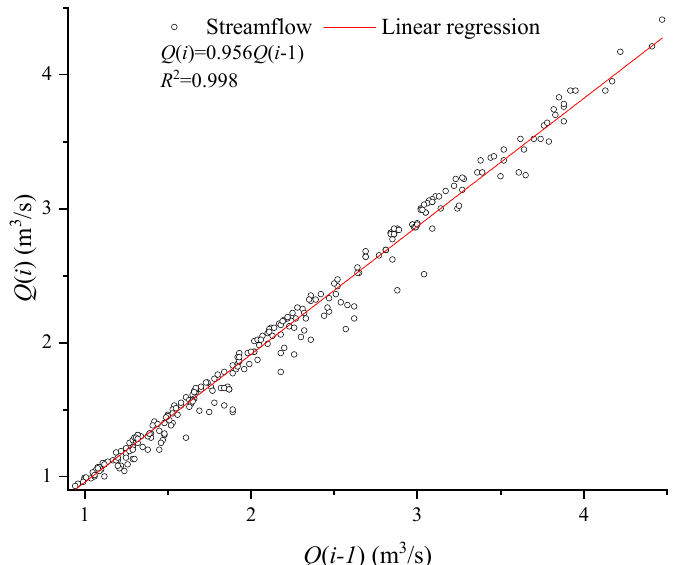
Figure 6. Scatter plot of streamflow Q ( i ) against Q ( i − 1 ) during recession period.